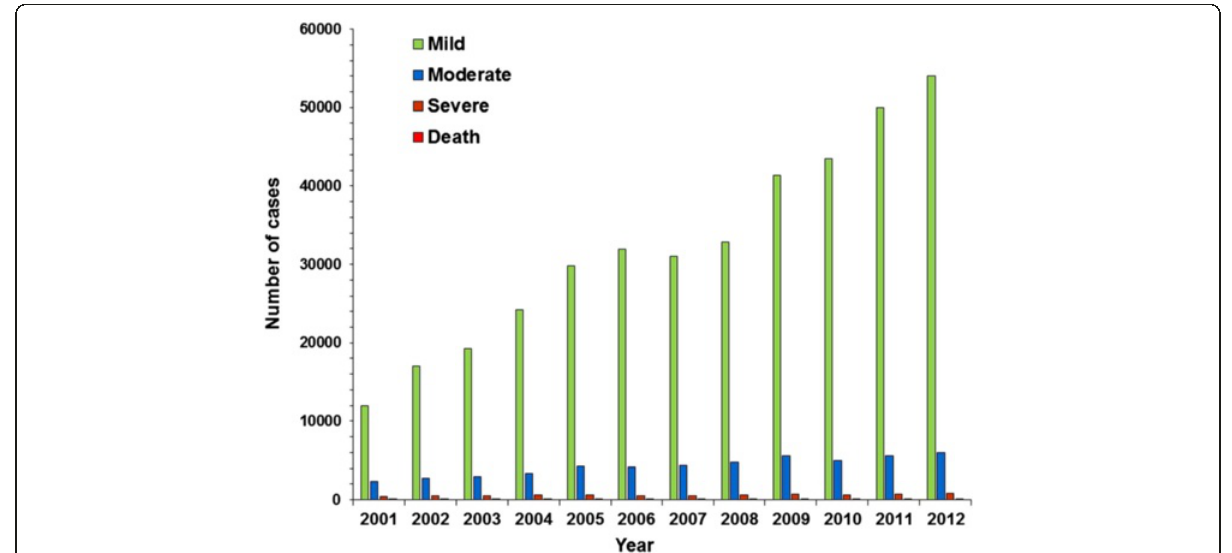
Fig. 14 Classification of scorpion stings from 2001 to 2012 in Brazil